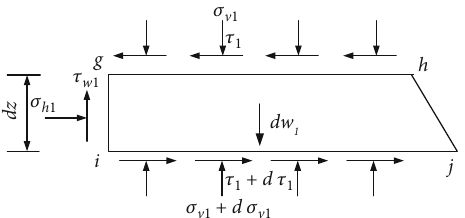
Figure 4: Stresses acting on horizontal elements in zone